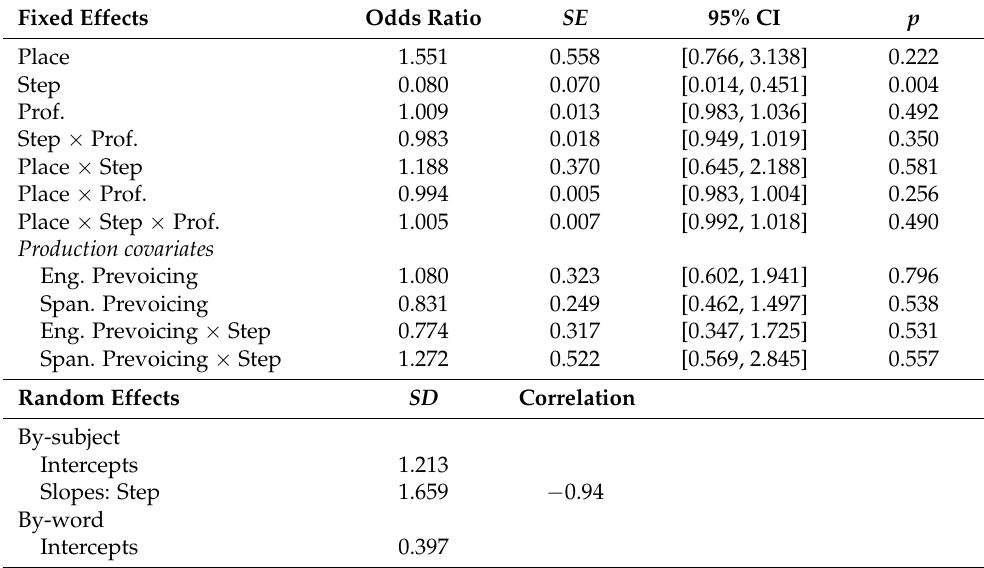
Table 5. Summary of ordinal mixed-effects model fit to the ratings for voiced targets.